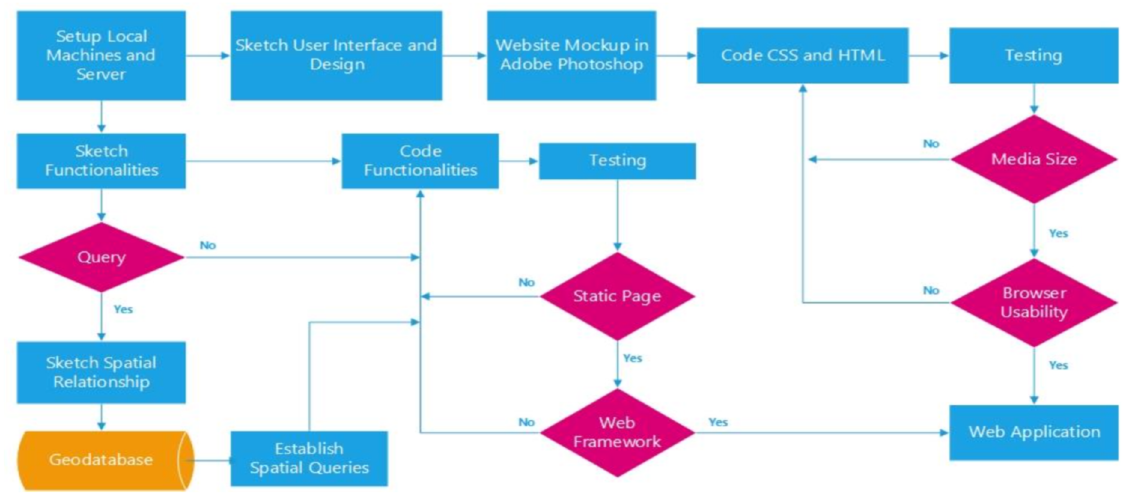
Figure 2. Backend and Frontend development